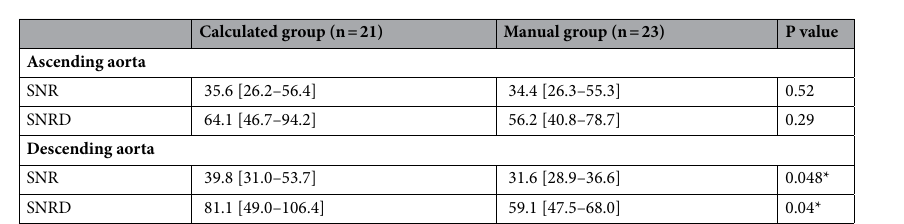
Figure 3. Box-and-whisker plots of patient positioning performance in the calculated and manual groups. The median (horizontal line within box), interquartile range (box), and nonoutlier range (whiskers) defined as 1.5 times the interquartile range. The largest deviations from the scanner isocenter, outside the nonoutlier range, are plotted as open dots. ( a ) Isocenter distance. The positive and negative values above and below the isocenter, respectively. ( b ) Absolute distance. ( c ) Distance ratio, defined as the ratio of the absolute isocenter distance to the body thickness.